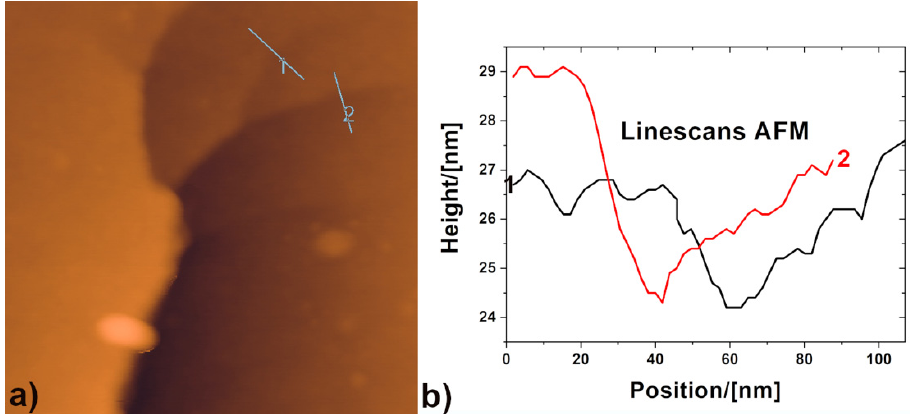
Figure 4. ( a ) NC-AFM performed on the in situ sample after deformation. Two line scans (blue lines) were measured across the in situ generated shear band branches. ( b ) Corresponding profiles of the line scans indicated in ( a ), revealing a thickness reduction in the form of a meniscus across the shear bands.